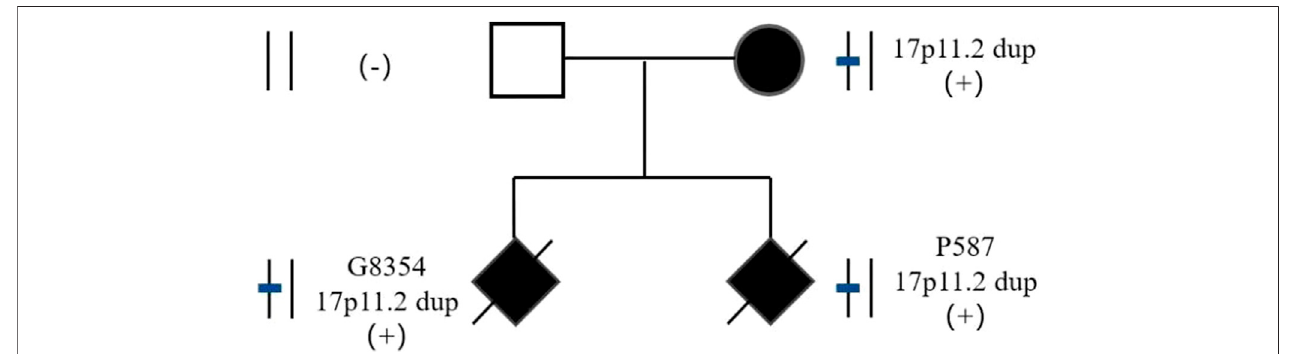
FIGURE 2 | Pedigree of two fetuses in consecutive pregnancies with 17p11.2